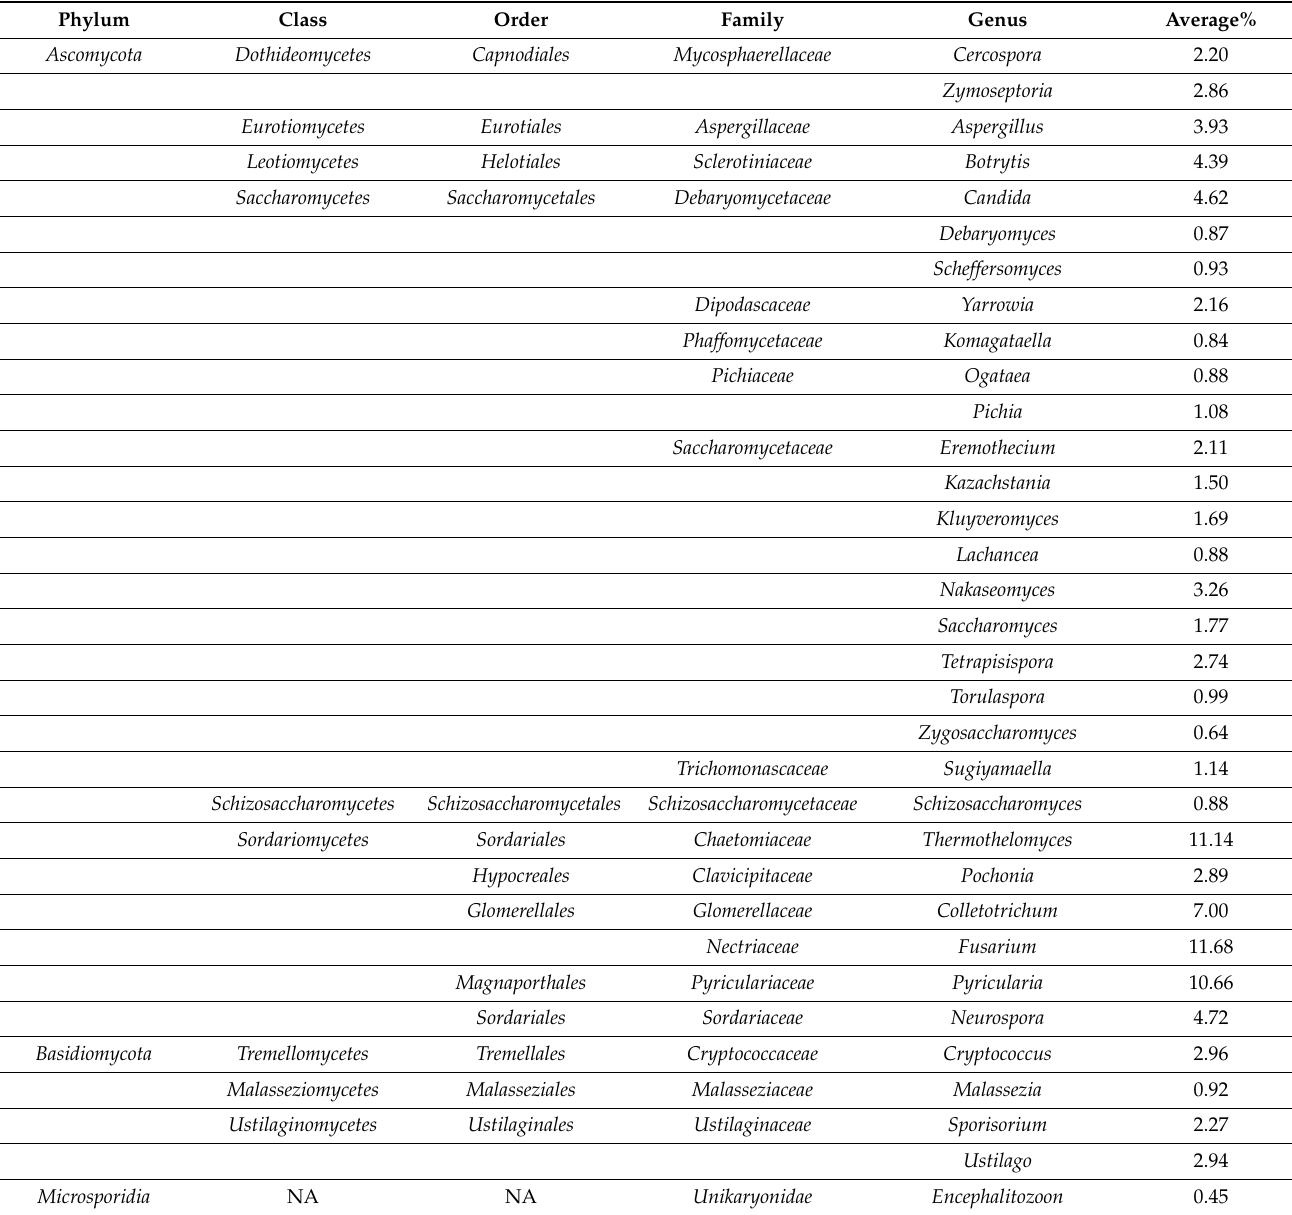
Table 3. Fungal taxonomic classification at phyla, class, order, family, and genera level. Average of the relative abundance (%) of the four layers. NA: no assigned at that level of classification.